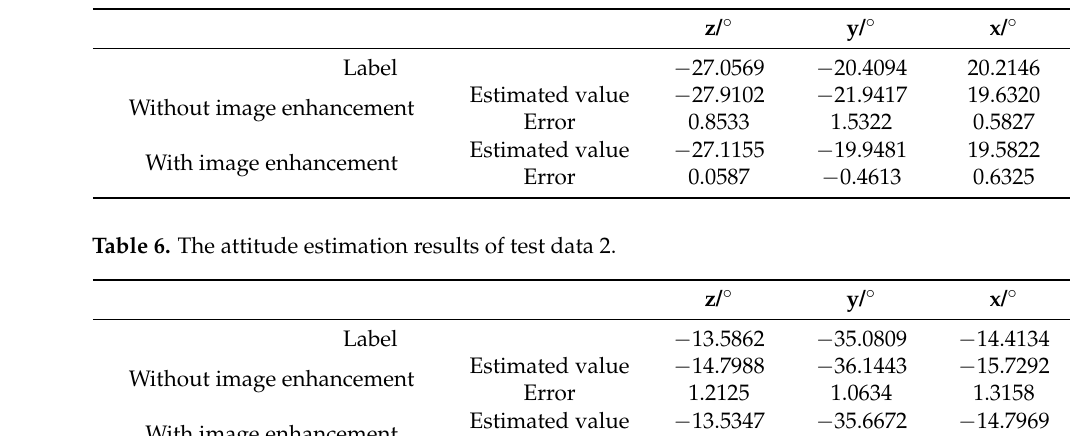
Figure 11. The imaging results of test data 2. Table 5. The attitude estimation results of test data 1. Table 6. The attitude estimation results of test data 2.